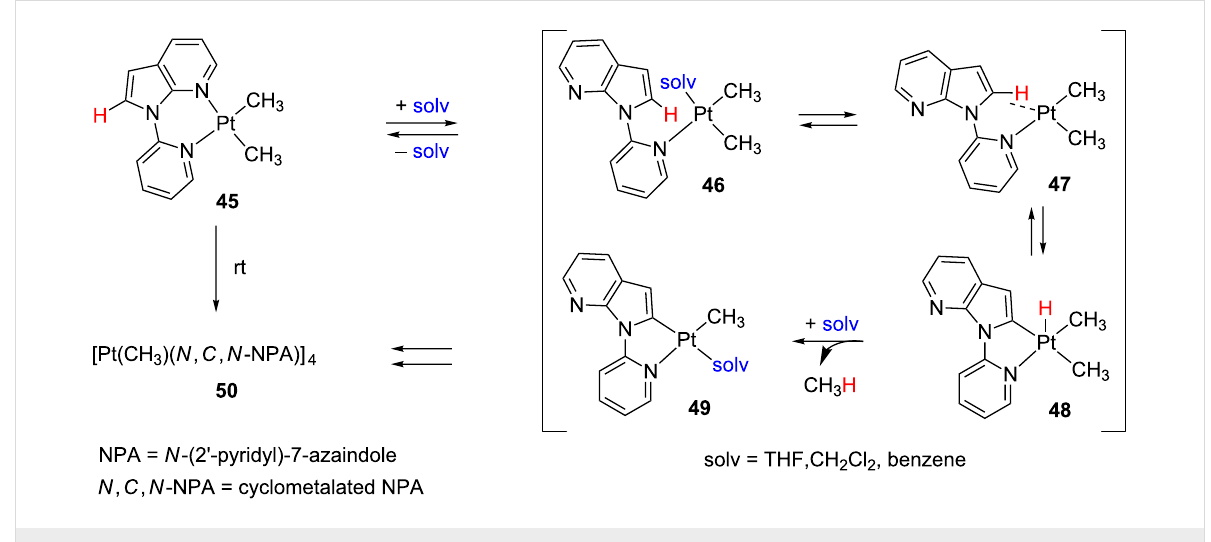
Scheme 21: Self-assembling process of 45 by “rollover” reaction [126].